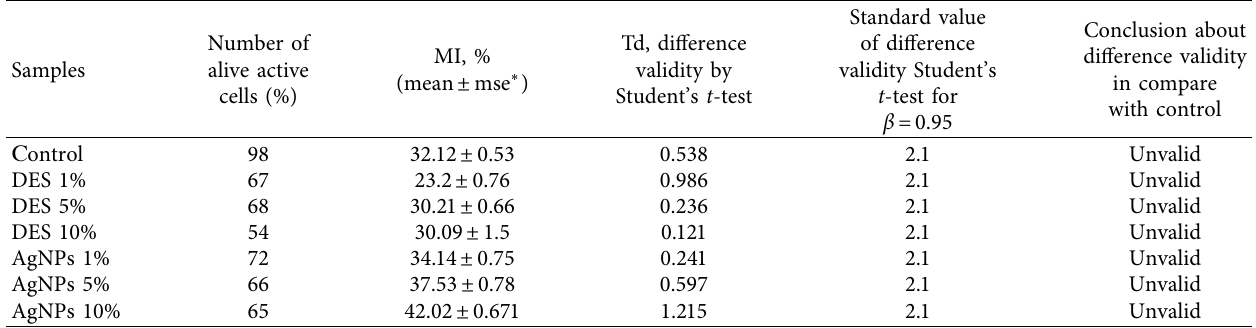
Table 6: Number of alive active cells, their MI calculations and diference validity between samples and control.